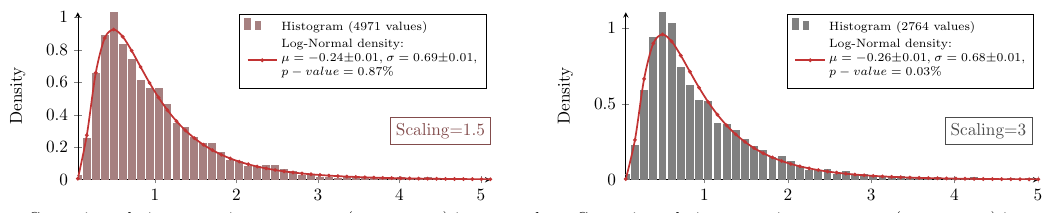
Figure 4. Measured and log-normal fit density of the retracement X in an up-trend and down-trend with scaling one for S&P100 stocks. Each dataset is visualized with a histogram from zero to five with a bin size of 0.11.